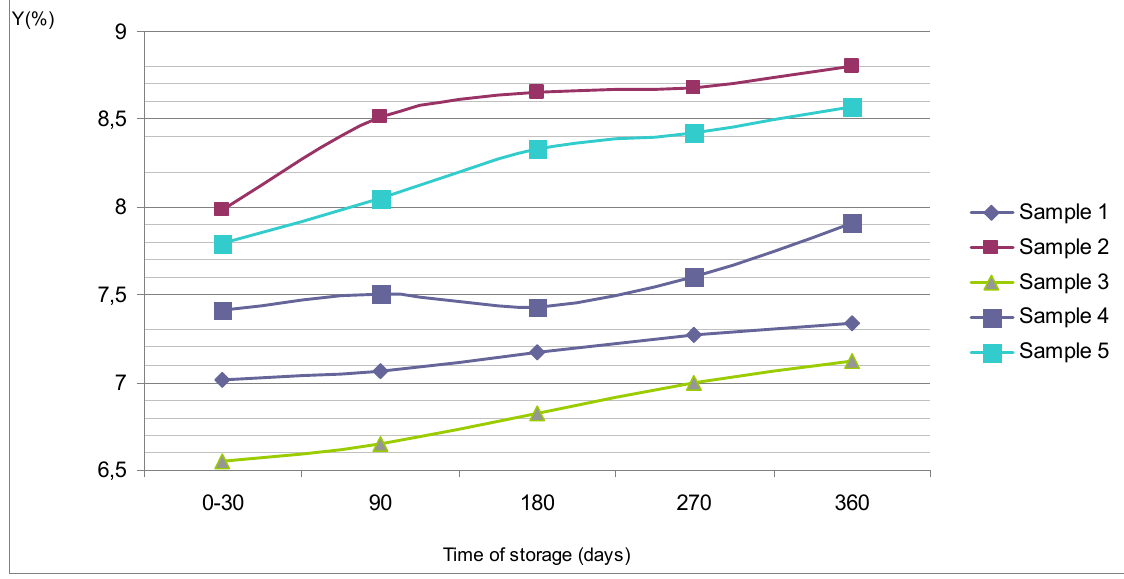
Figure 2 . Changes of average reflectance (Y, %) on the top surface of samples of dietary chocolates during storage of 360 days.